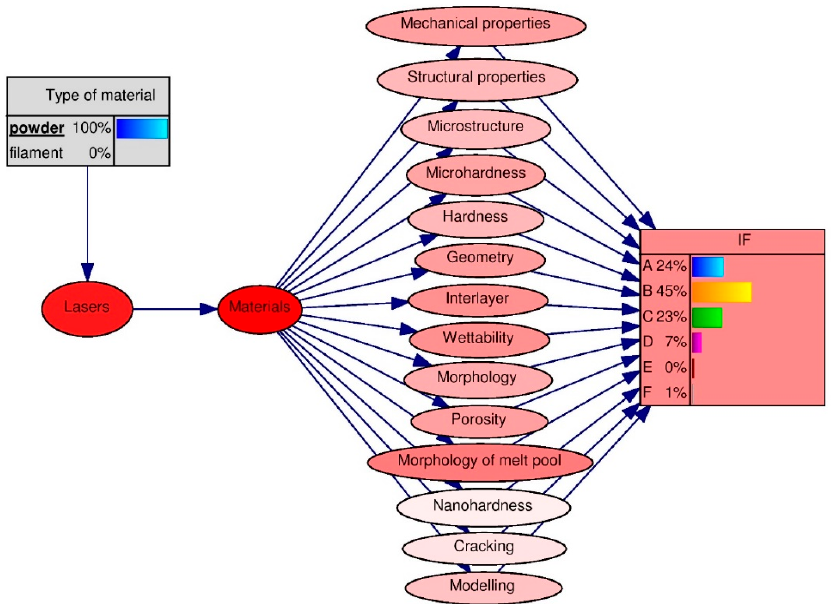
Figure 8. Expert knowledge levels of new technologies obtained via investigations of single-track features in laser processing, for studies performed using powder materials and the IF—the impact factor of the journal in which the research article was published. The level of expert knowledge in the journal with a specific IF index was: A = 24% (IF ≤ 2), B = 45% (2 < IF ≤ 3), C = 23% (3 < IF ≤ 4), D = 7% (4 < IF ≤ 5), E = 0% (5 < IF ≤ 6), F = 1% (IF >